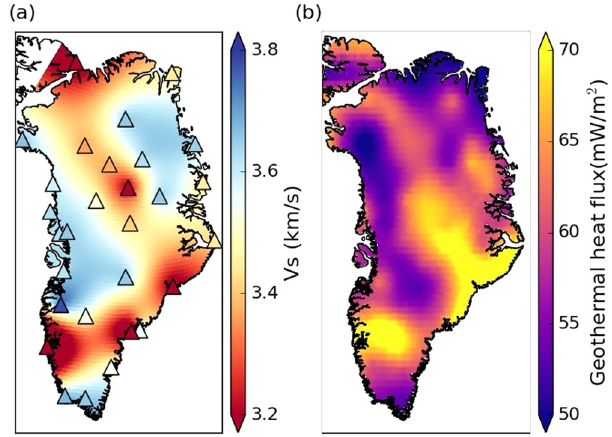
Fig. 8 Comparison between V s and geothermal heat fl ux model. a V s at 4 km depth calculated at each seismic station (triangle) and interpolated onto a 0.25 ∘ × 0.25 ∘ grid. b Geothermal heat fl ux at the ice-bedrock interface taken from Martos et al. 3